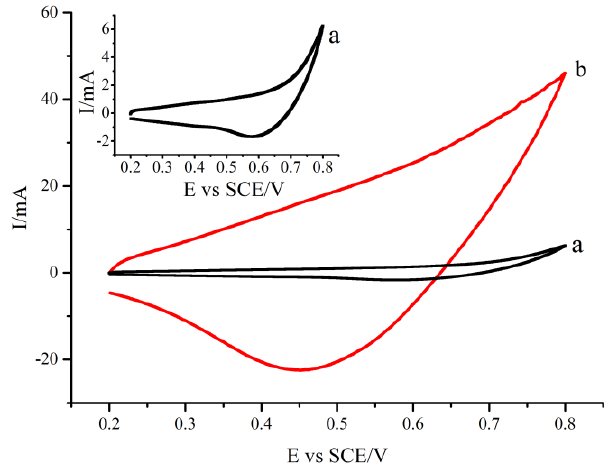
Figure 3. CV curve recorded at the CuNWE (a) and CuO/CuNWE (b) in a 0.075 M NaOH solution at a scan rate of 0.05 V s −1 . Inset is the magnified view of curve a.